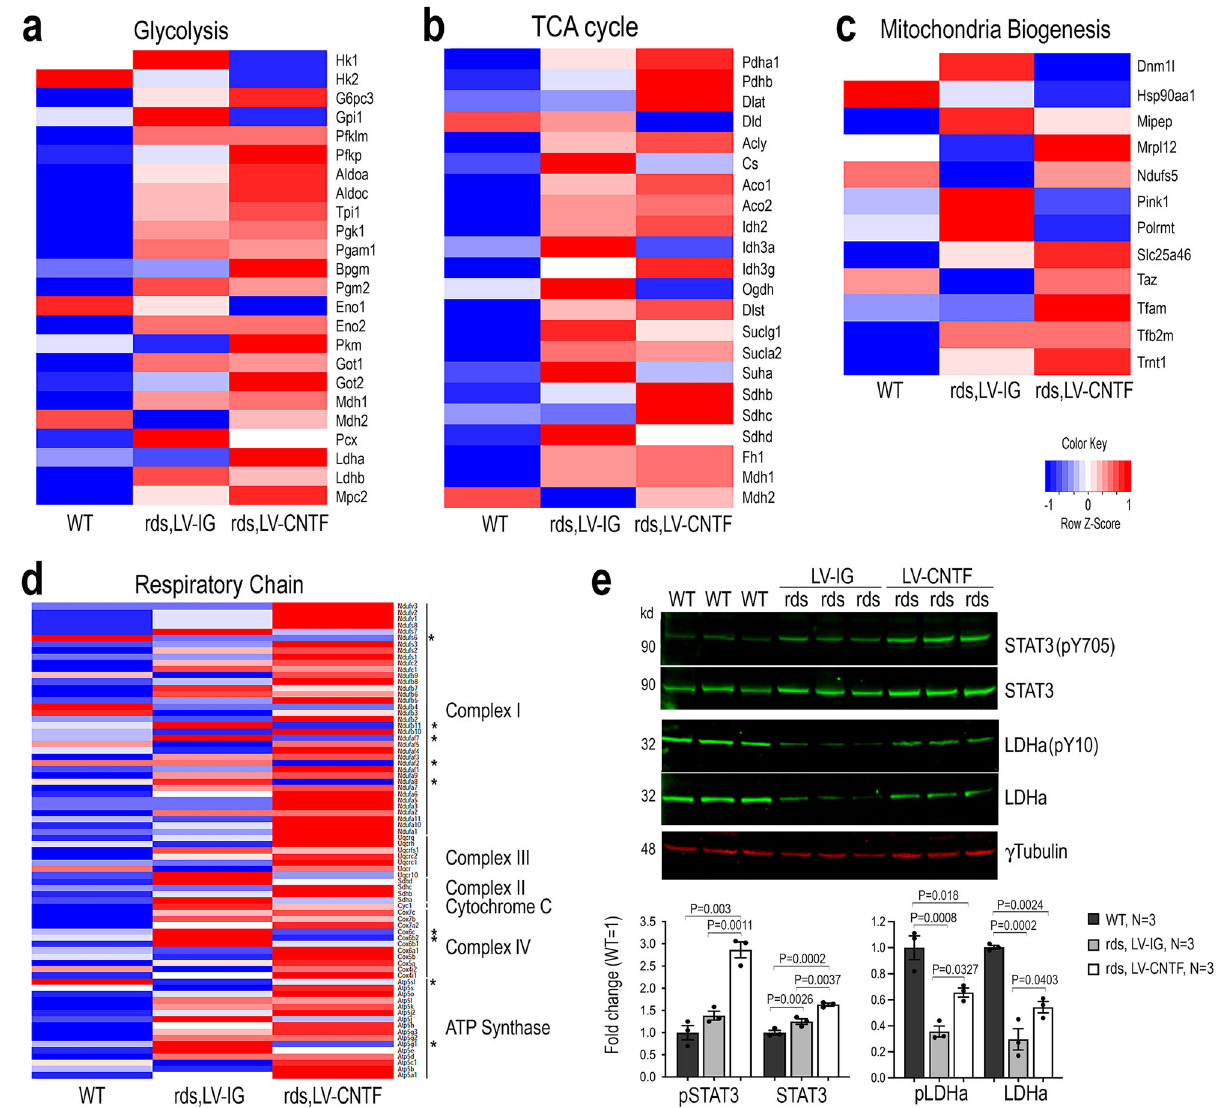
Fig. 6 | In fl uence of CNTF on metabolic gene expression and enzyme activity. a – d Transcriptome analysis of WT retina and rds retinas treated with LV-IG or LV- CNTF from P25-P35. Heatmaps show relative transcript levels (average of N =3, each N contains two retinas). a Glycolytic pathway enzymes and Mpc2. b Mitochondrial Pdha1, Pdhb, and TCA cycle enzymes. c Participants of mito- chondrial biogenesis. d Nuclear genome encoded mitochondrial respiratory chain